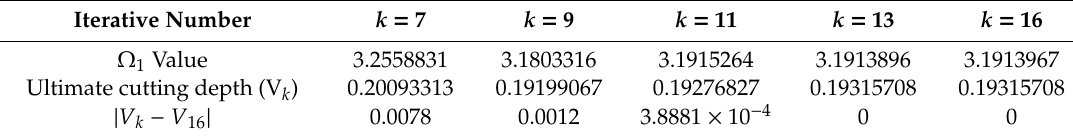
Table 3. Five values of di ff erent iteration number.